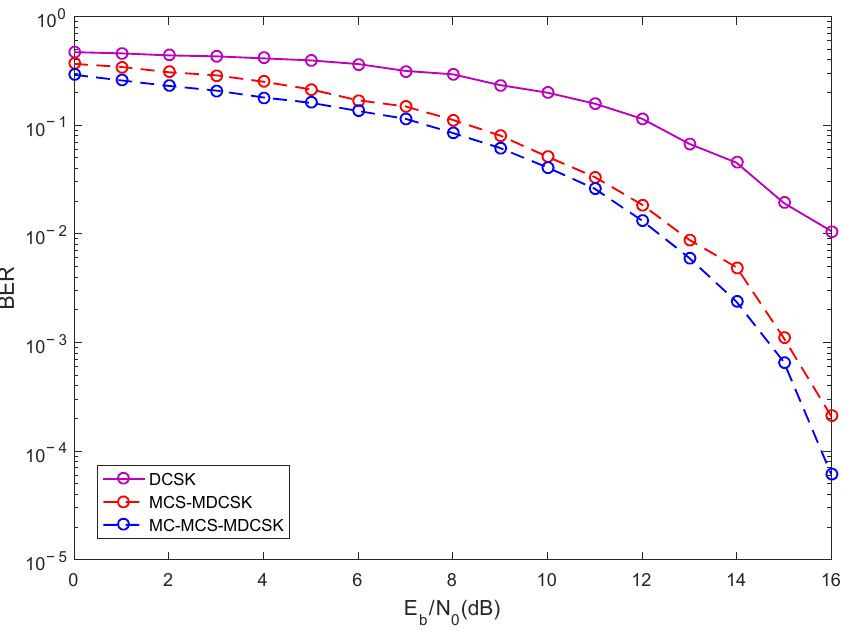
Figure 6. Comparisons of the BER performances between the proposed MC-MDCSK-MCS system and other non-coherent chaotic communication systems over the AWGN channel.